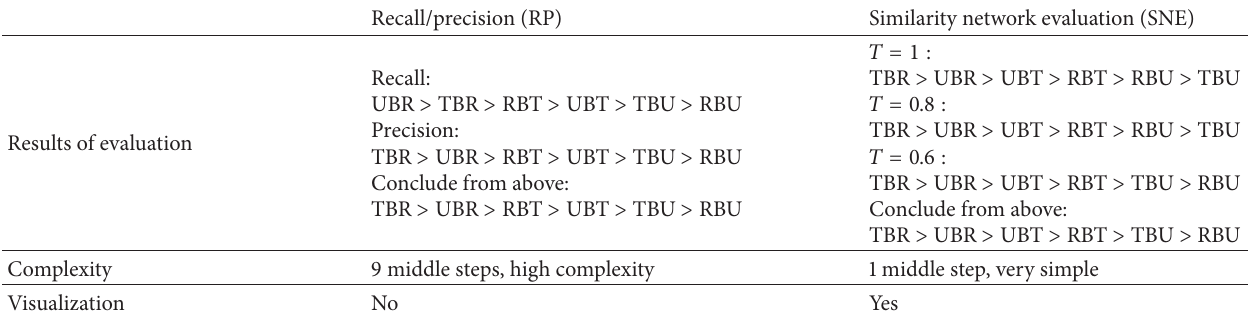
Table 6: Comparison analysis of RP and